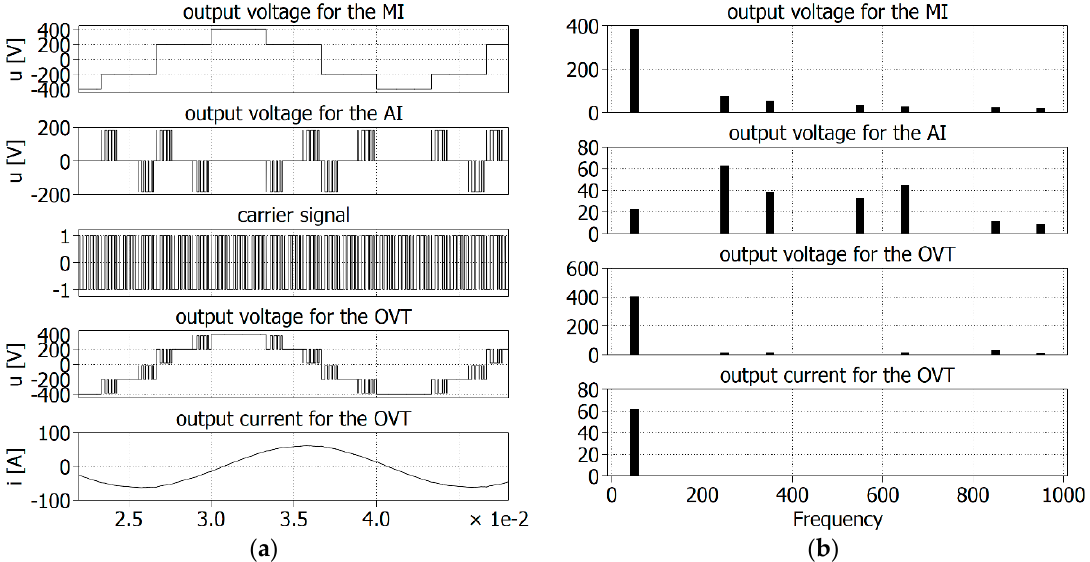
Figure 15. The voltage and current waveforms ( a ) for the OVT inverter under resistive loads and their spectra ( b ) with the use of a PWM generator.